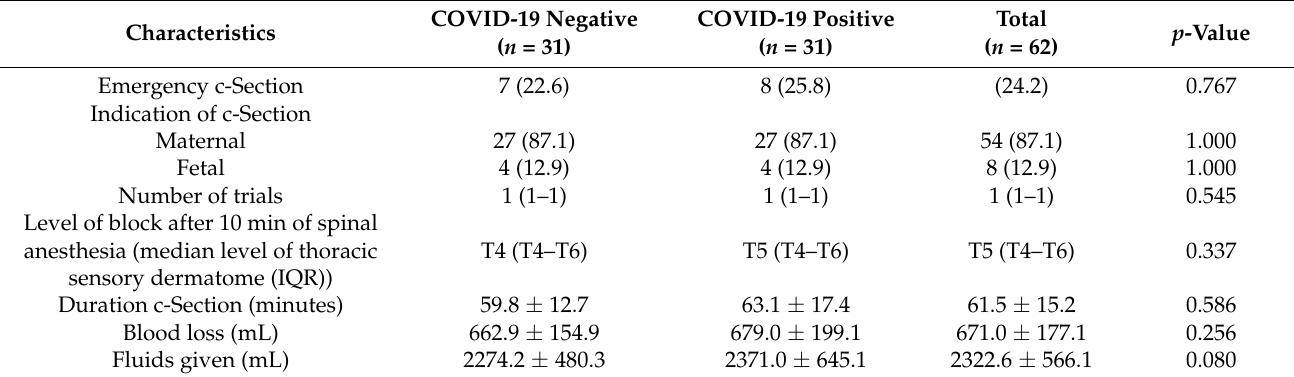
Table 3. Operative data and intraoperative events.